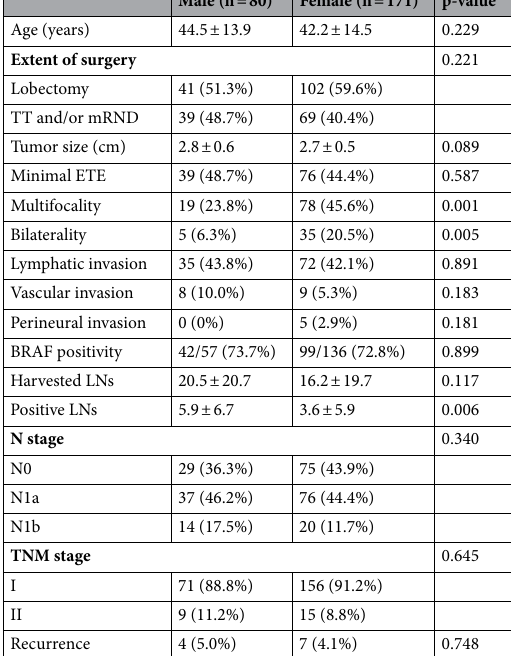
Table 2. Baseline clinicopathological characteristics according to sex. Data were expressed as number (%) or mean ± standard deviation. A statistically significant difference was defined as p < 0.05. TT total thyroidectomy, mRND modified radical neck dissection, ETE extrathyroidal extension, LN lymph node, T tumor, N node.